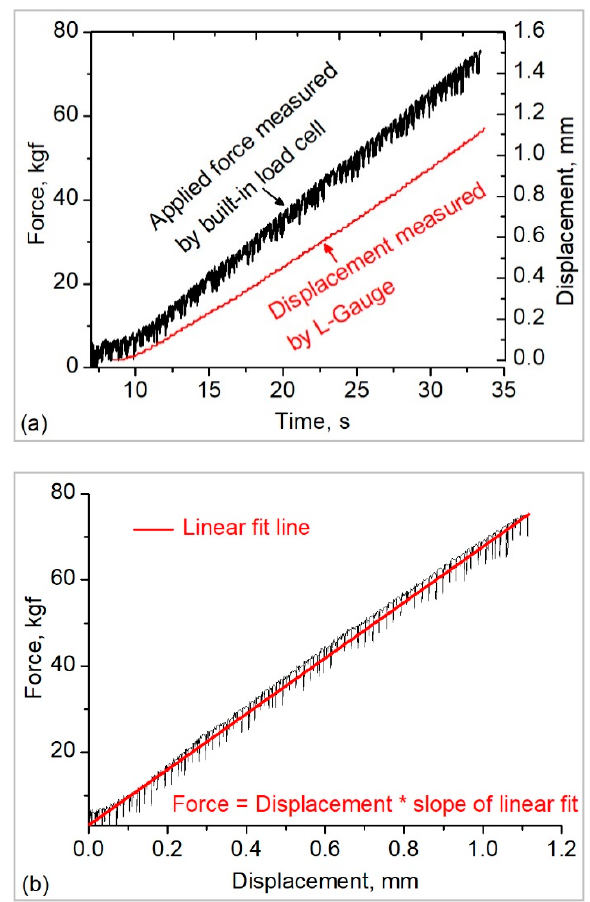
Figure 5. Evolution of the applied force and the relationship between applied force and displacement: ( a ) the applied force measured using the built-in load cell and the displacement of restrained jaw relative to base of Gleeble with time, and ( b ) the linear relationship between applied force (from built-in load cell) and displacement (measured using L-gauge) of restrained jaw relative to the base of the Gleeble unit. The red curve in ( b ) is a linear fit, from which the slope is determined.